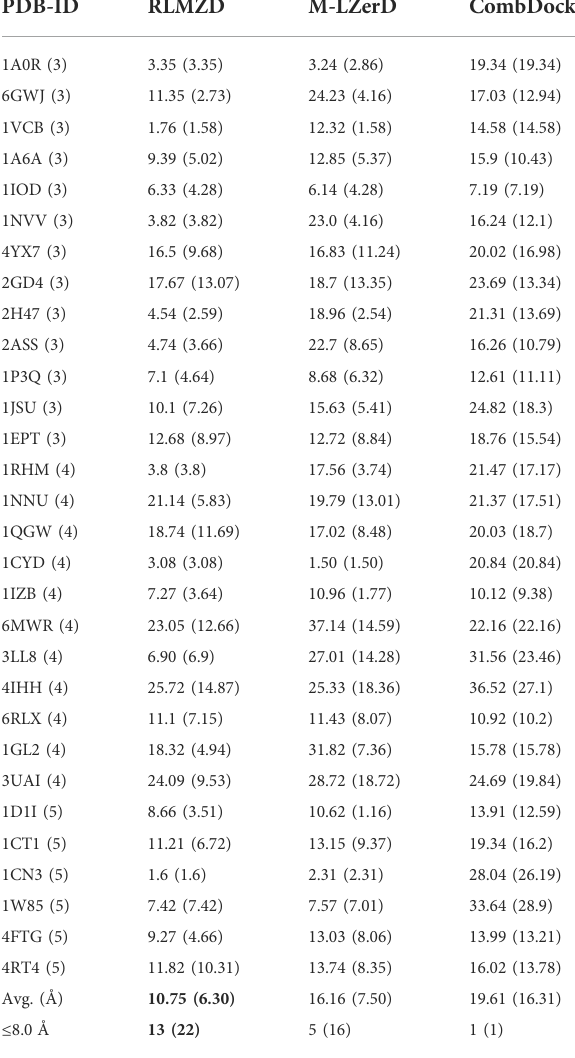
TABLE 2 Summary of unbound docking